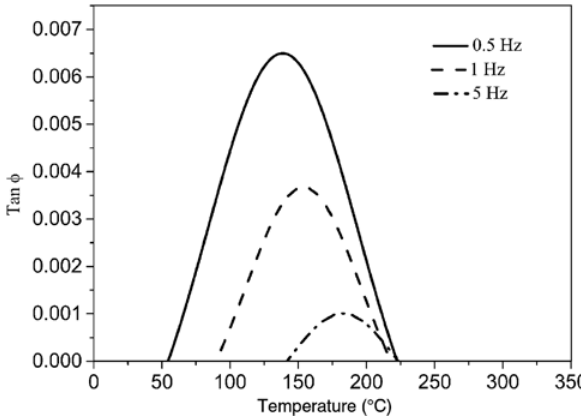
Figure 6: Temperature dependence of damping capacity under dif- ferent frequencies of 6 wt.% FAC/AZ91D composites. Figure 7: Damping peak of fitting for 6 wt.% FAC/AZ91D